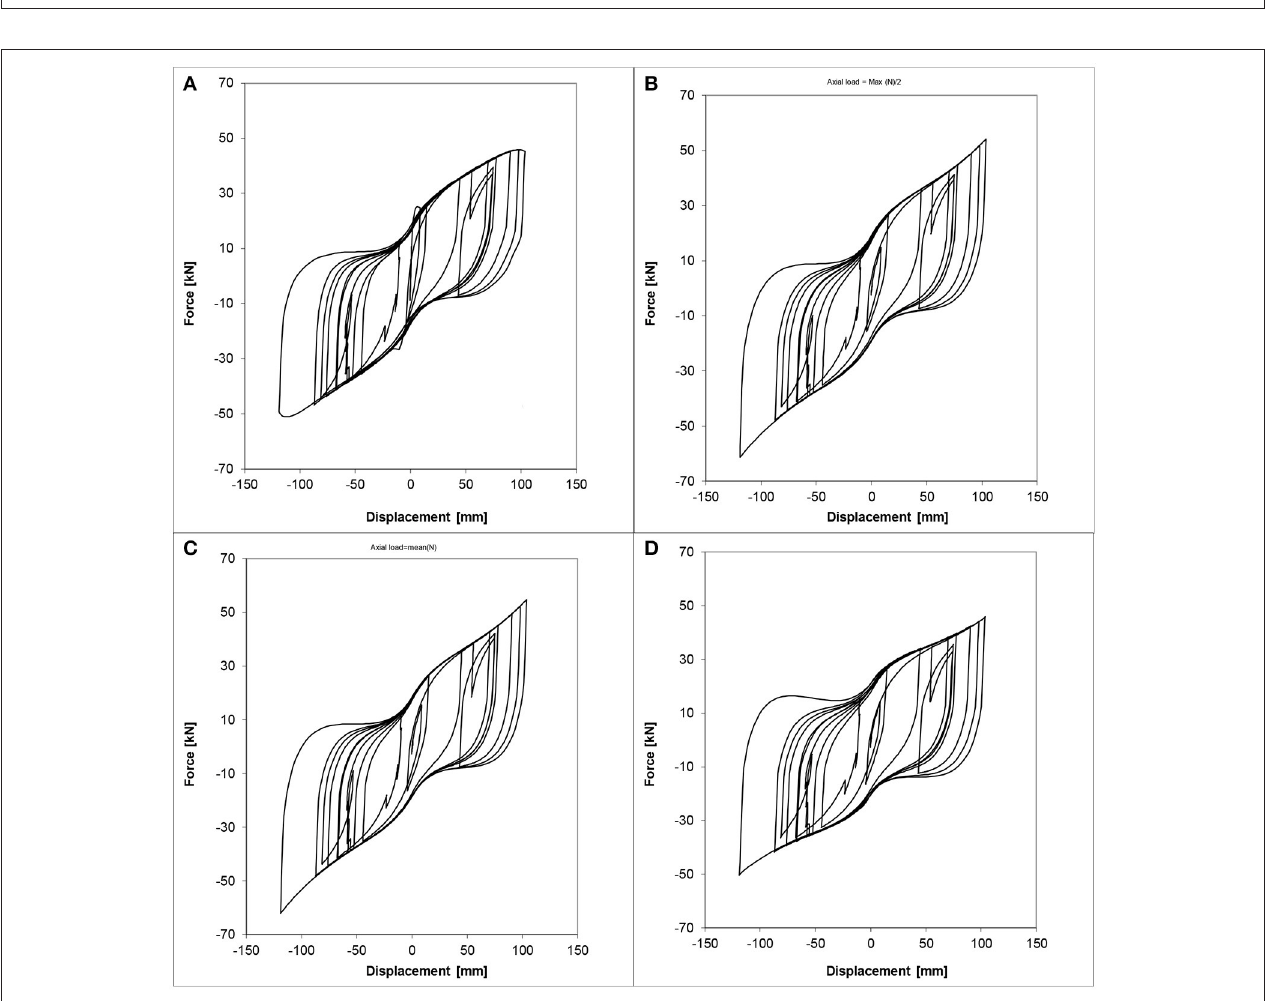
FIGURE 13 | Lead–rubber bearing shear force–displacement hysteresis loops for device #2 with: (A) varying vertical load, (B) 9.5 MPa constant vertical stress (half of the maximum value), (C) 8 MPa constant vertical stress (mean value), (D) 19 MPa constant vertical stress (maximum value).